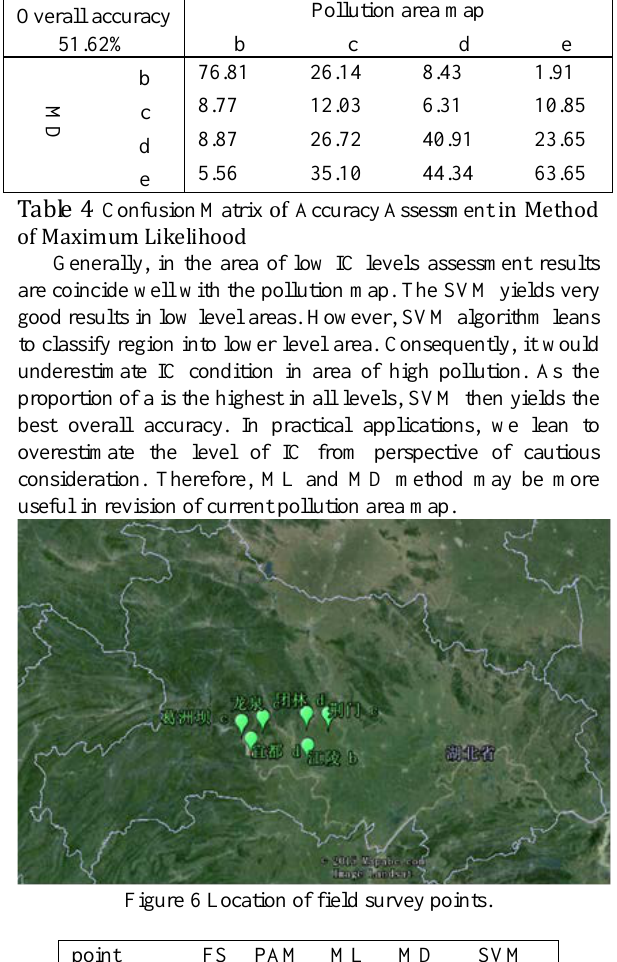
Figure 5 assessment results of different classification algorithms. From top to bottom, maximum likelihood, support vector machine and mahalanobis minimum distance method respectively. Table 2-4 show the Pollution area map Overall accuracy confusion matrix of three different algorithms. 54.96% Confusion Matrix Accuracy Assessment of in Method of Maximum Likelihood Overall accuracy Confusion Matrix Accuracy Assessment of